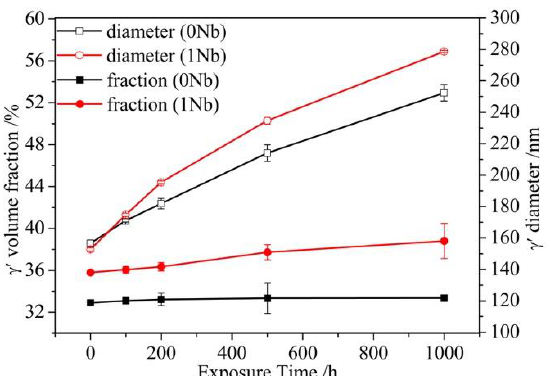
Figure 6. γ´ size and volume fraction evolution during long -term thermal exposure at 800 °C up to 1000 1000 h. Figure 6. γ ´ size and volume fraction evolution during long ‐ term thermal exposure at 800 °C up to 1000 h.